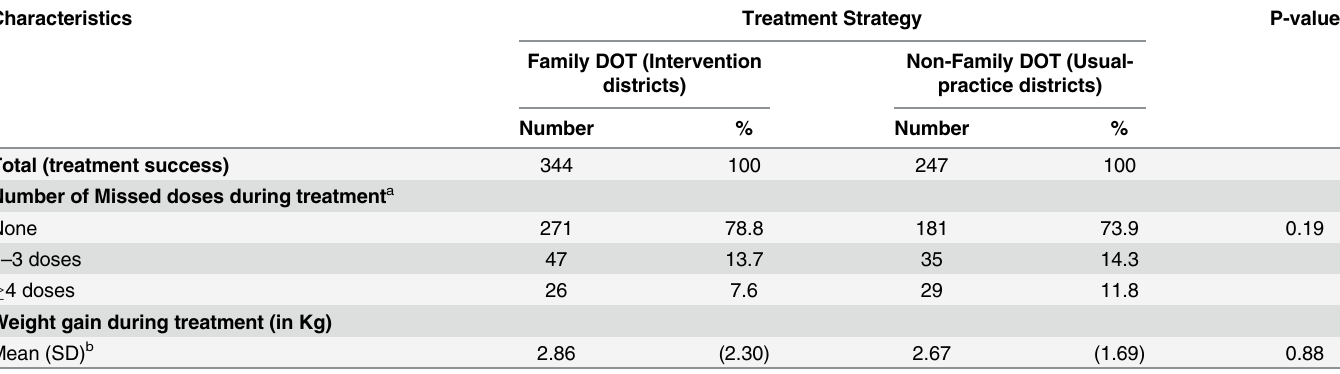
a Treatment card was missing information on dosage information for 2 children. Chi-square test was used for assessing difference between the proportions. b Weight gain could not be determined for 46 children whose end of treatment information weight was missing. We used Wilcoxon Mann Whitney test (a non-parametric test) for assessing statistical signi fi cance since the variable was not normally